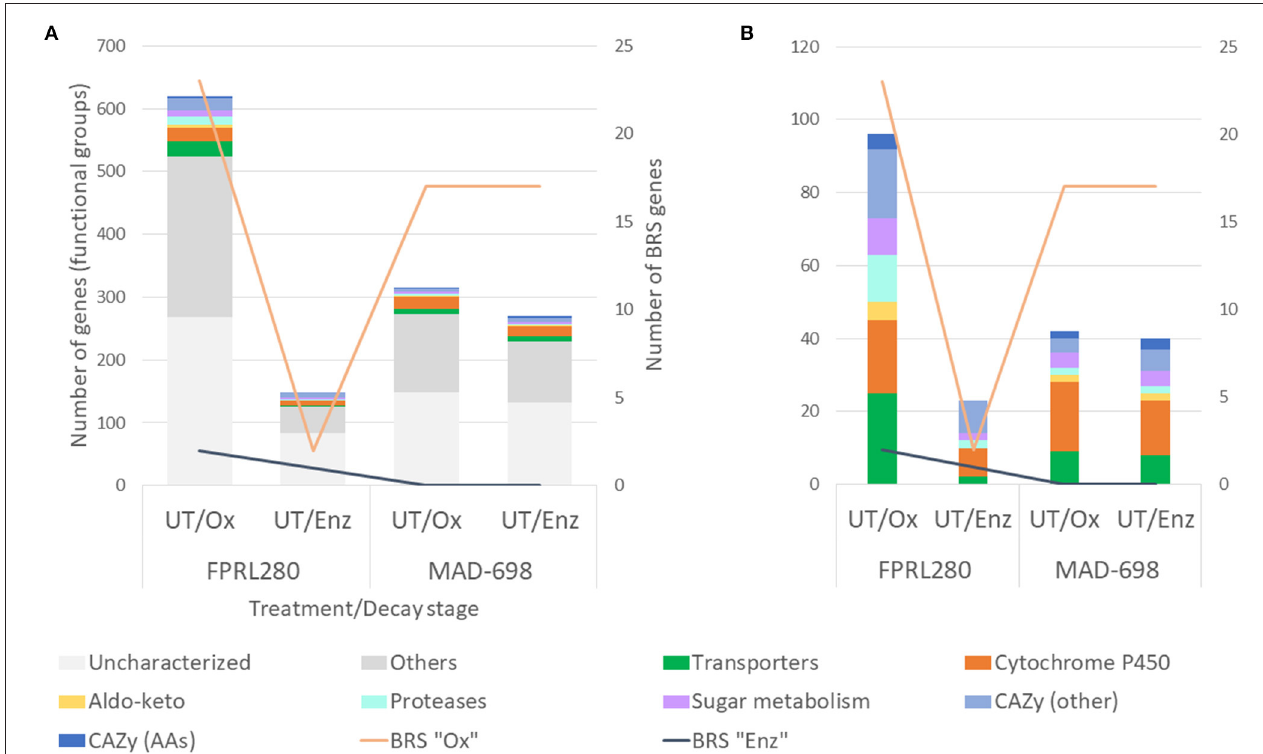
FIGURE 4 | Differential expression analysis, comparing the two R. placenta strains during two decay stages on untreated samples: (A) Genes, grouped by the gene ontology functional groups: Transporters, Cytochrome P450, CAZys and genes encoding proteins that are involved in sugar metabolism, Aldo-keto reductases, Proteases, genes with other functions and uncharacterized genes. (B) Same as in (A) , but excluding the groups “Others” and